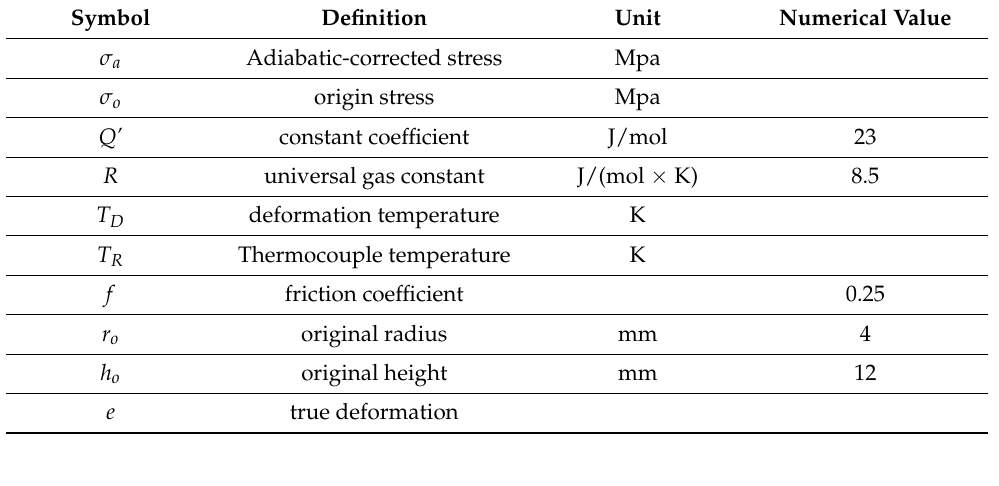
Table 5. Meaning of stress correction parameters.